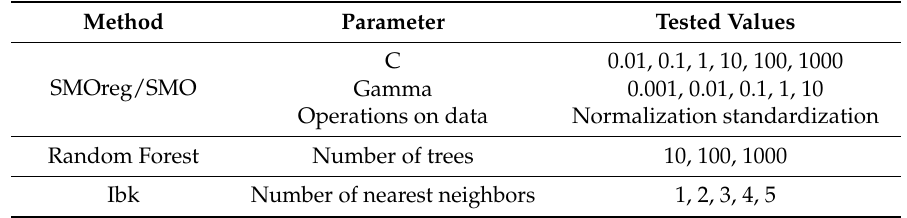
Table 6. Optimization conditions for SMOreg, SMO, Random Forest, and IBk.